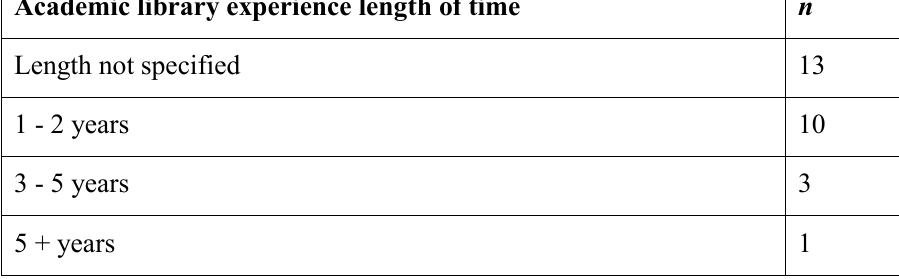
Table 6 : Length of time for experience working in an academic library as a